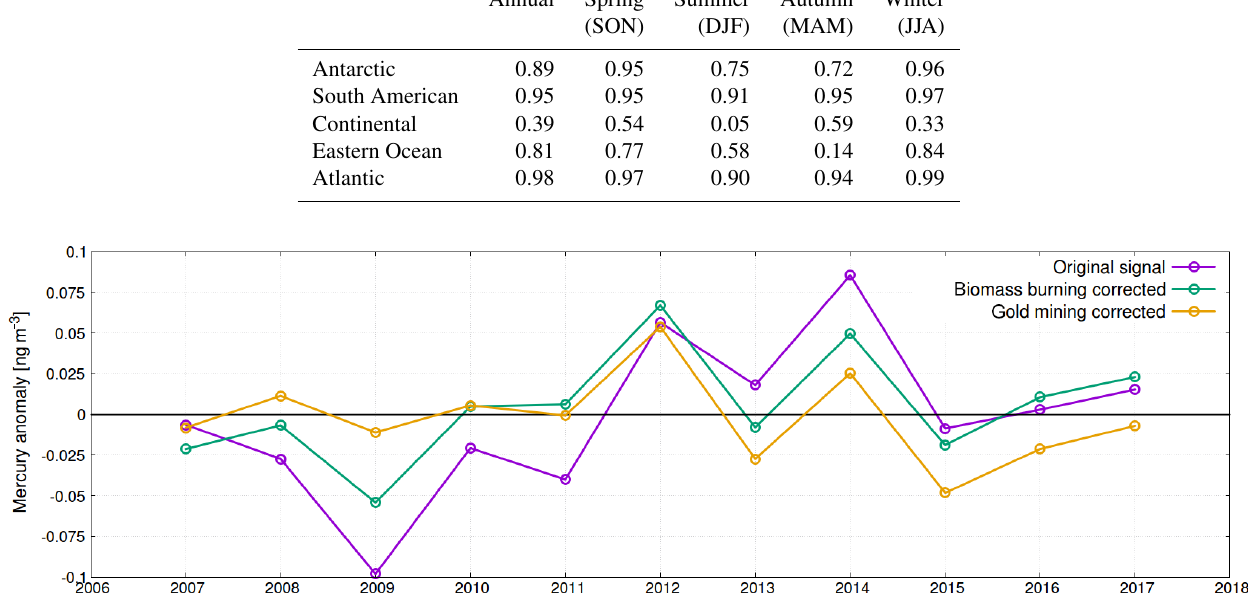
Figure 11. Annual anomaly from 10-year average mercury concentrations. Original dataset at Cape Point (purple), corrected for biomass burning emissions (green) (Jiang et al., 2017) and additionally corrected for gold mining emissions (orange) (Streets et al.,